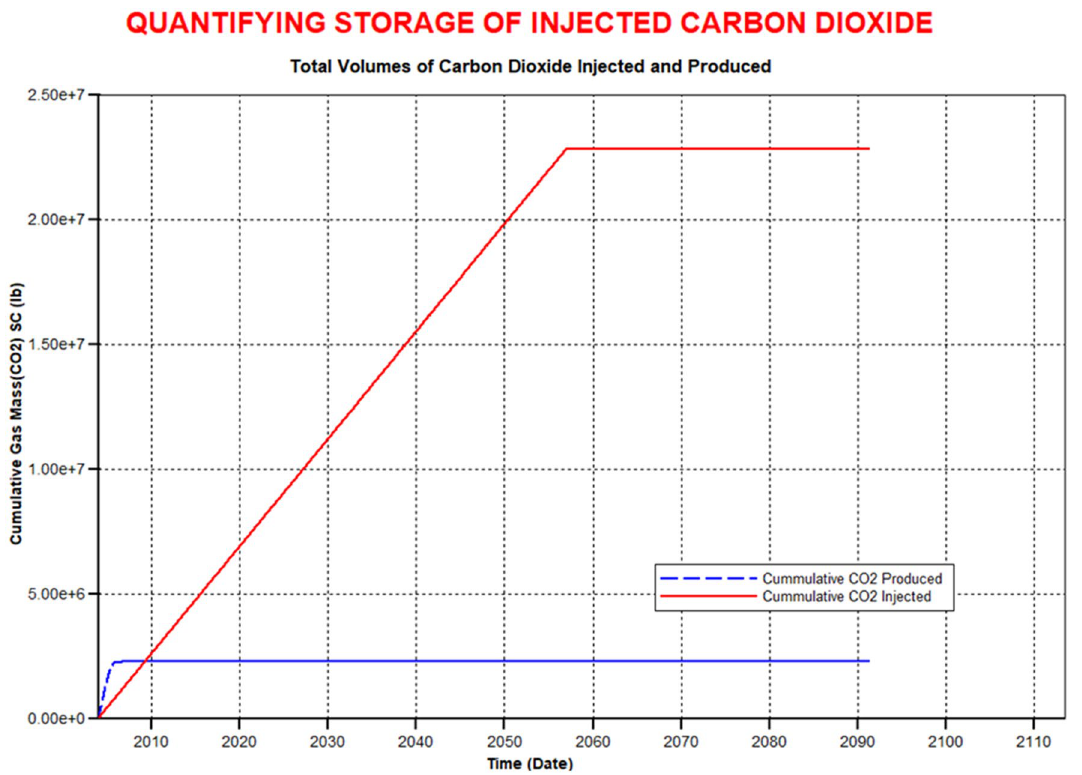
Fig. 10 Illustration of total volume of carbon dioxide injected, and total volume of carbon dioxide produced during combined CO